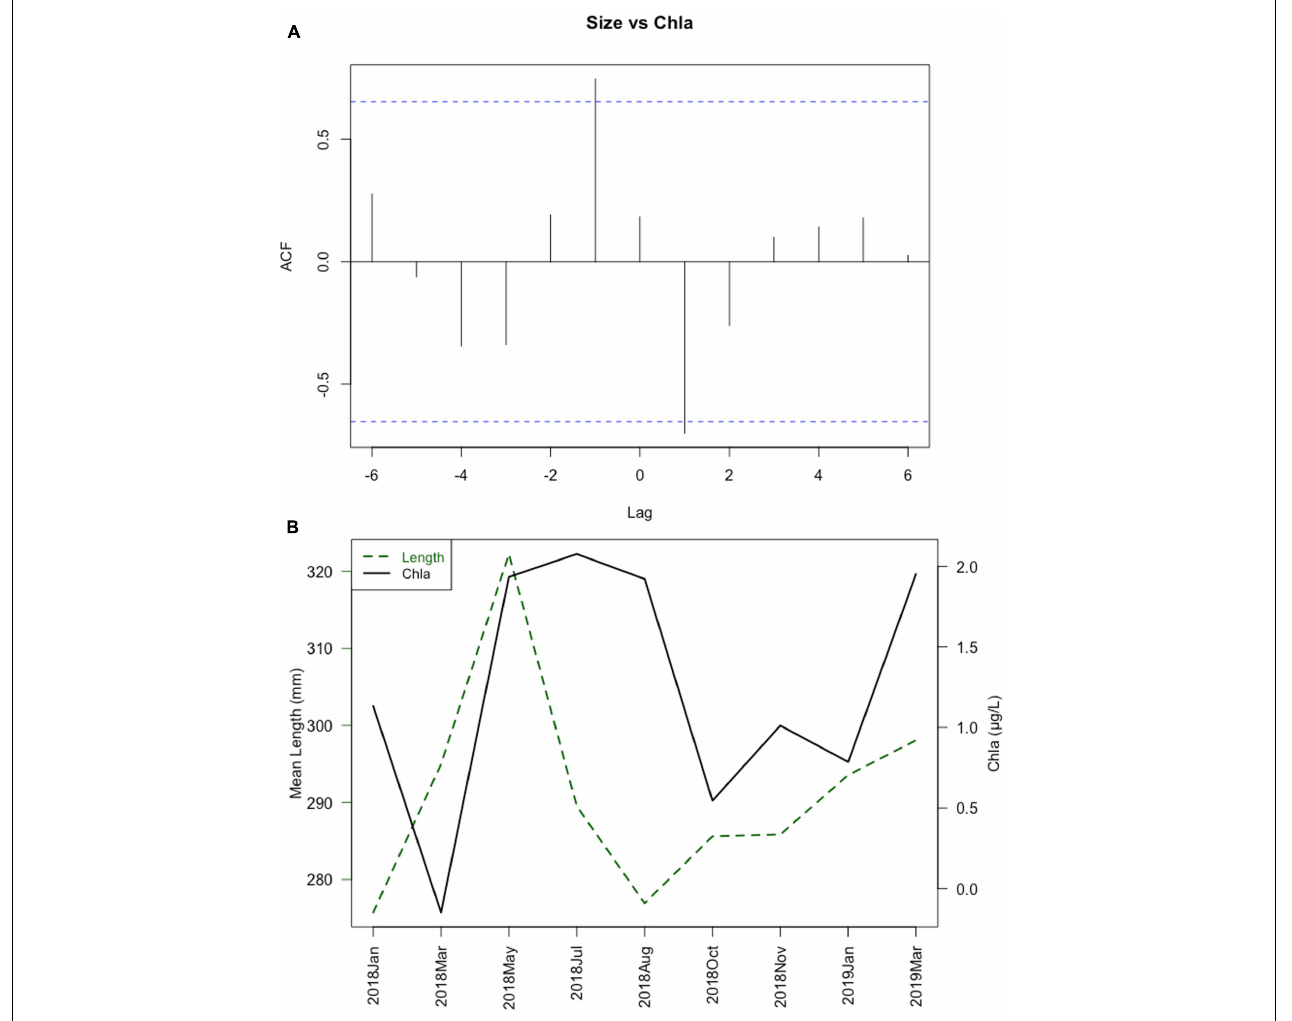
FIGURE 10 | Cross-correlation analysis for the time series of Chl a and mean total length of Holothuria mammata , at Arrábida, Setúbal, during the nine month sampling period: (A) ACF plot depicting correlations (vertical lines) and significance threshold (horizontal dotted lines); (B) average monthly values for Chl a and mean total